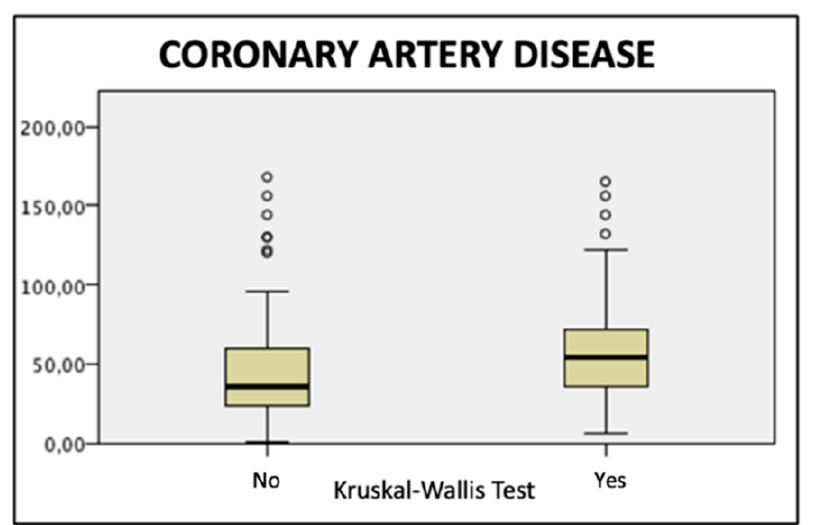
Figure 1. One-way analysis of variance (ANOVA), Kruskal–Wallis test, showing a highly statistical association ( p = 0.00023) between coronary artery disease and refractory TIIEL occurrence.